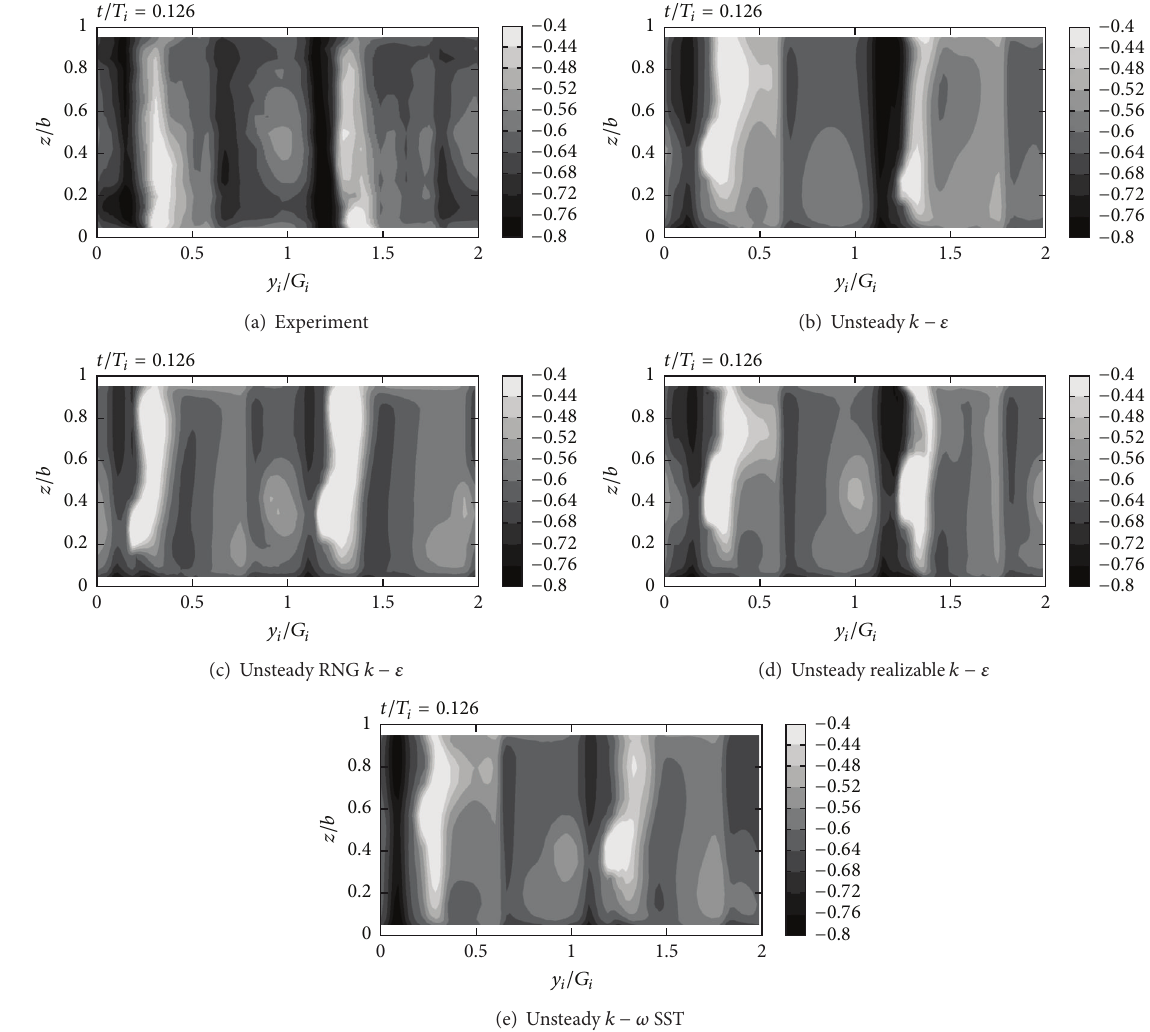
Figure 16: Tangential velocities in the radial gap ( 𝑅/𝑅 2 = 1.02